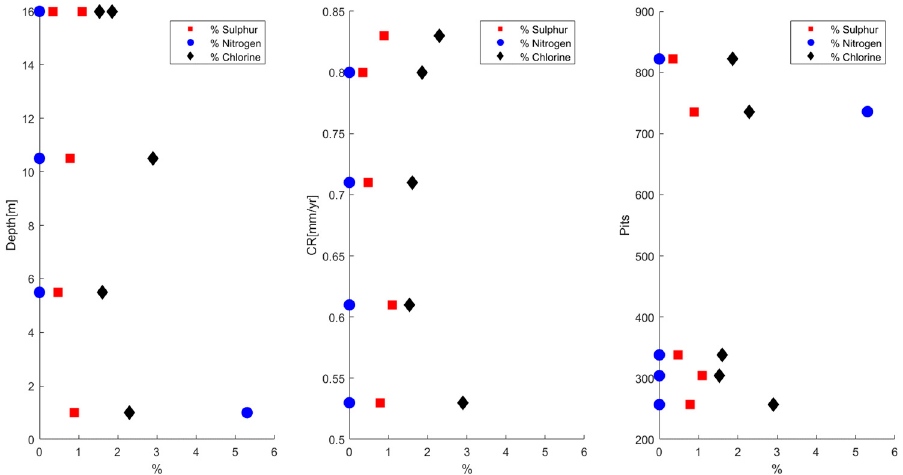
Figure 12. % composition vs. water depth, corrosion rate (CR), and number of pits.